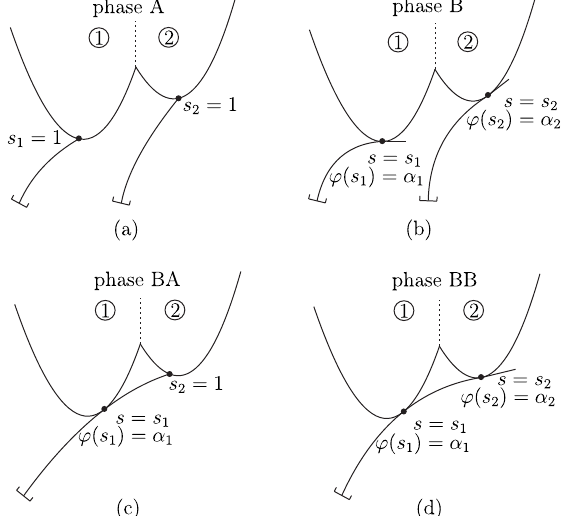
Figure 2. Contact phases–Phase A ( a ) and B ( b ) with single-point contact (SPC), phase BA ( c ) and BB ( d ) with two-point contact